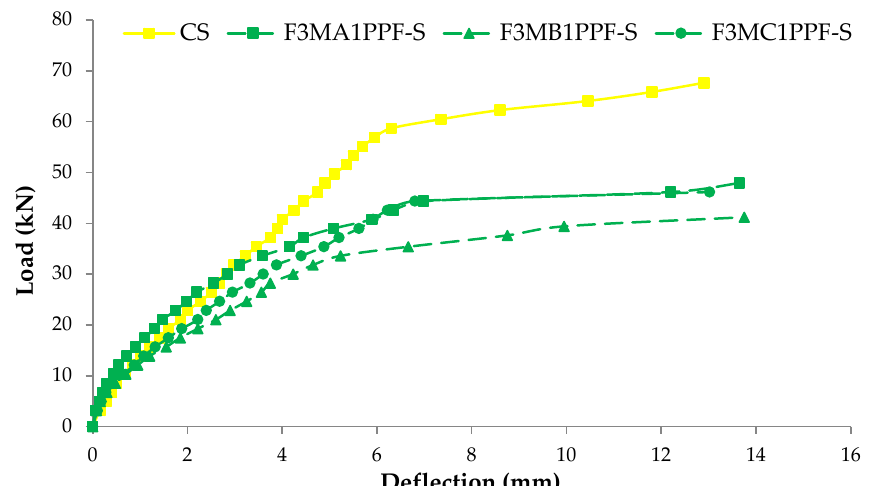
Figure 16. Comparison of load-deflection for different % of PPF and three steel wire mesh.